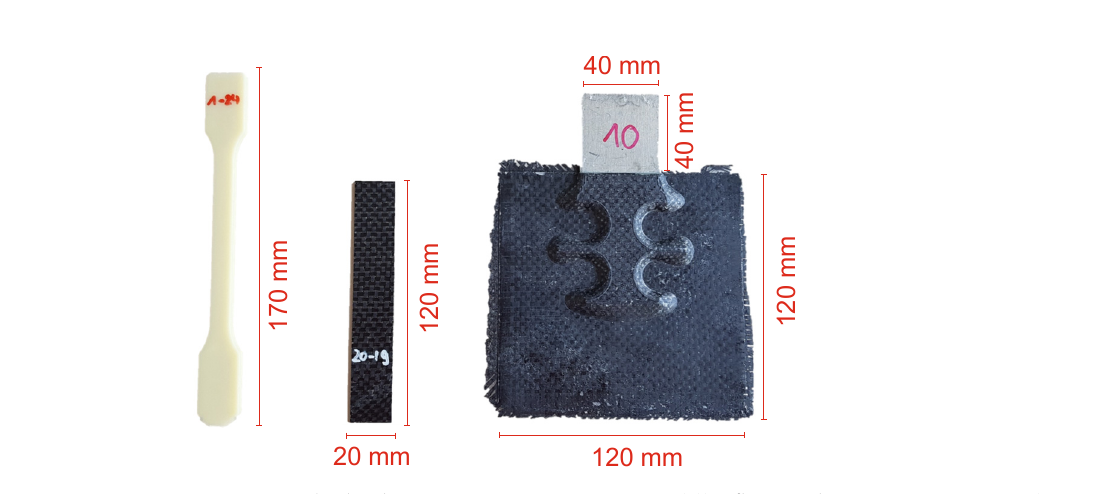
Figure 2. Left : dog bone PPA-GF30 specimen; middle : flat tensile CFRP specimen; right : assembled hybrid specimen.